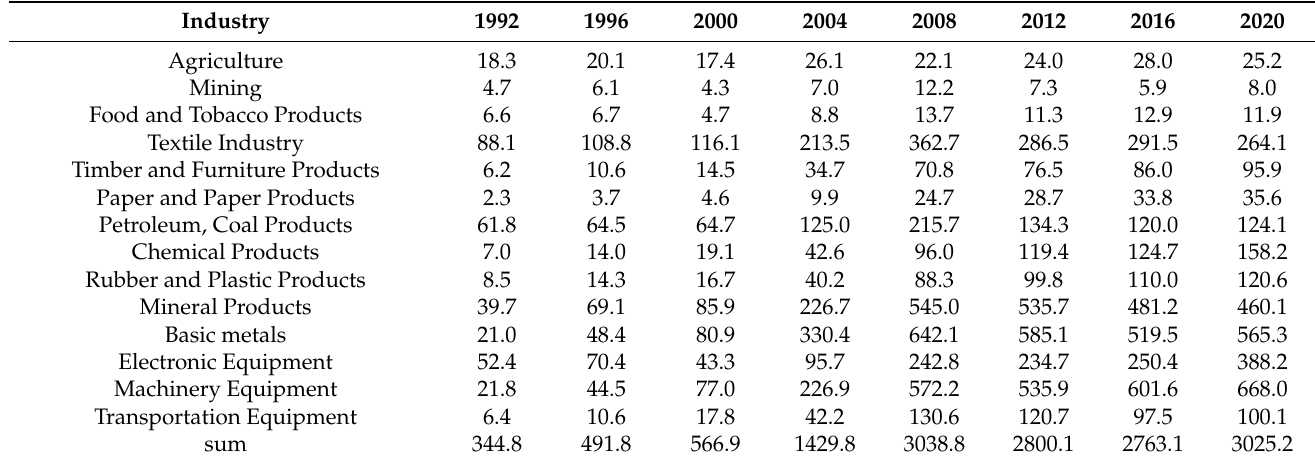
Table 2. The embodied carbon emissions in export by industry from 1992 to